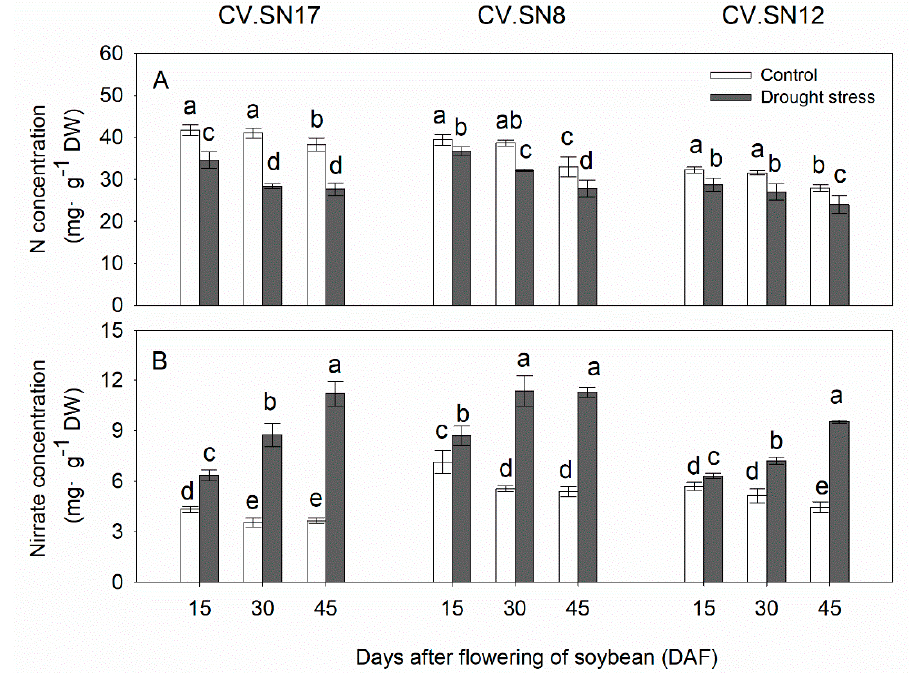
Figure 2. Changes of ( A ) nitrogen content and ( B ) nitrate content in leaves of CV.SN17, CV.SN8, and CV.SN12 under control and drought stress conditions. Data show the means ± standard deviation of three independent samples. Di ff erent letters above vertical bars indicate significant di ff erences between means at a p < 0.05 level.